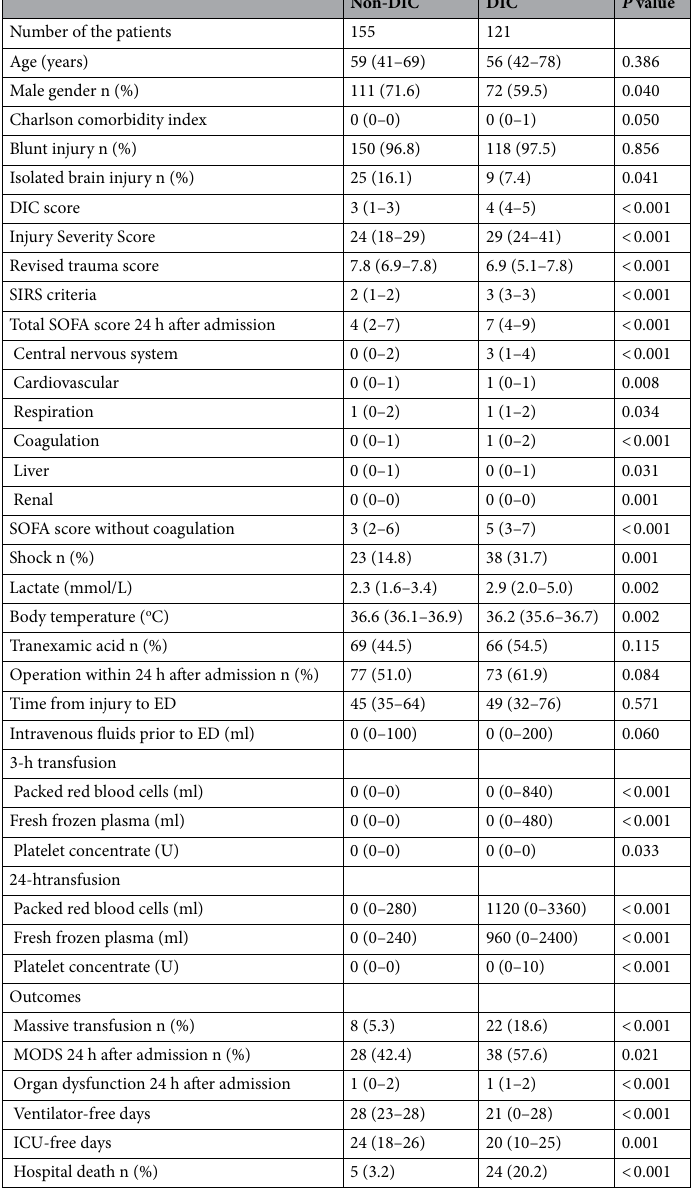
Table 1. Demographics of the patients on admission to the emergency department, volume of transfusion and outcomes. Values are expressed as the median with the 25th–75th interquartile range or number (percentage). DIC disseminated intravascular coagulation, ED emergency department, SIRS systemic inflammatory response syndrome, SOFA sequential organ dysfunction assessment, ICU intensive care unit, MODS multiple organ dysfunction syndrome. Missing data of Outcomes from upper to bottom, 5, 95, 95, 8, 35, 3,